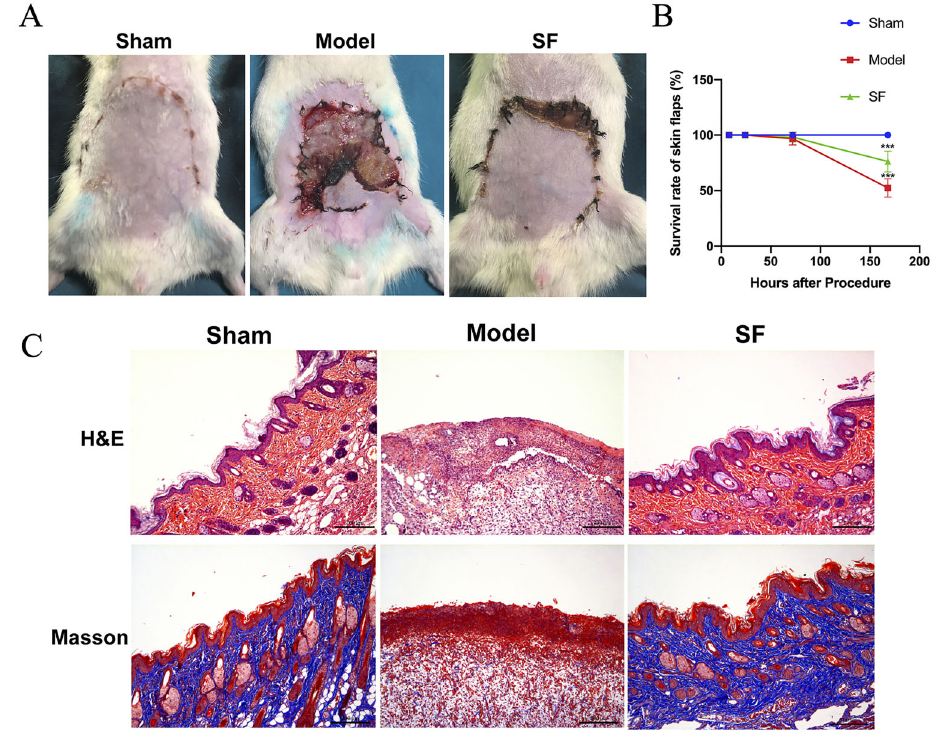
Figure 1. Morphological images of the A ) lesion area and B ) comparison of the percentage of the recovered skin fl ap area (%, mean ± SD, n=6 per group) after 7 days of establishment of the ischemia-reperfusion model in each group (***P o 0.001 compared to Sham, Student ’ s t -test). C , H&E staining of the fl ap tissue (top). Masson staining (bottom) suggests the improved synthesis of the collagen after sodium ferulate (SF) treatment. Scale bar, 200 m